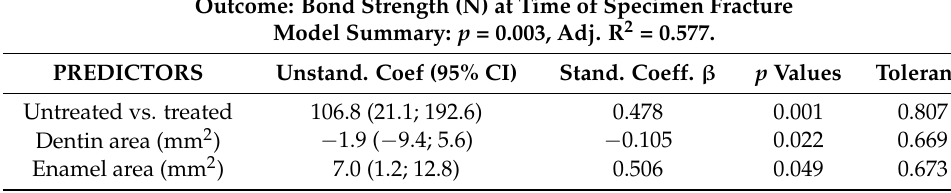
Table 2. Predictors of bond strength (Multivariable Linear Regression Model). Outcome: Bond Strength (N) at Time of Specimen Fracture